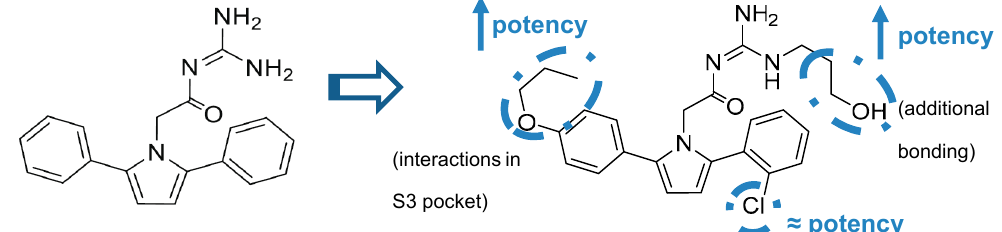
Figure 17. Optimization of 18 to 19 .